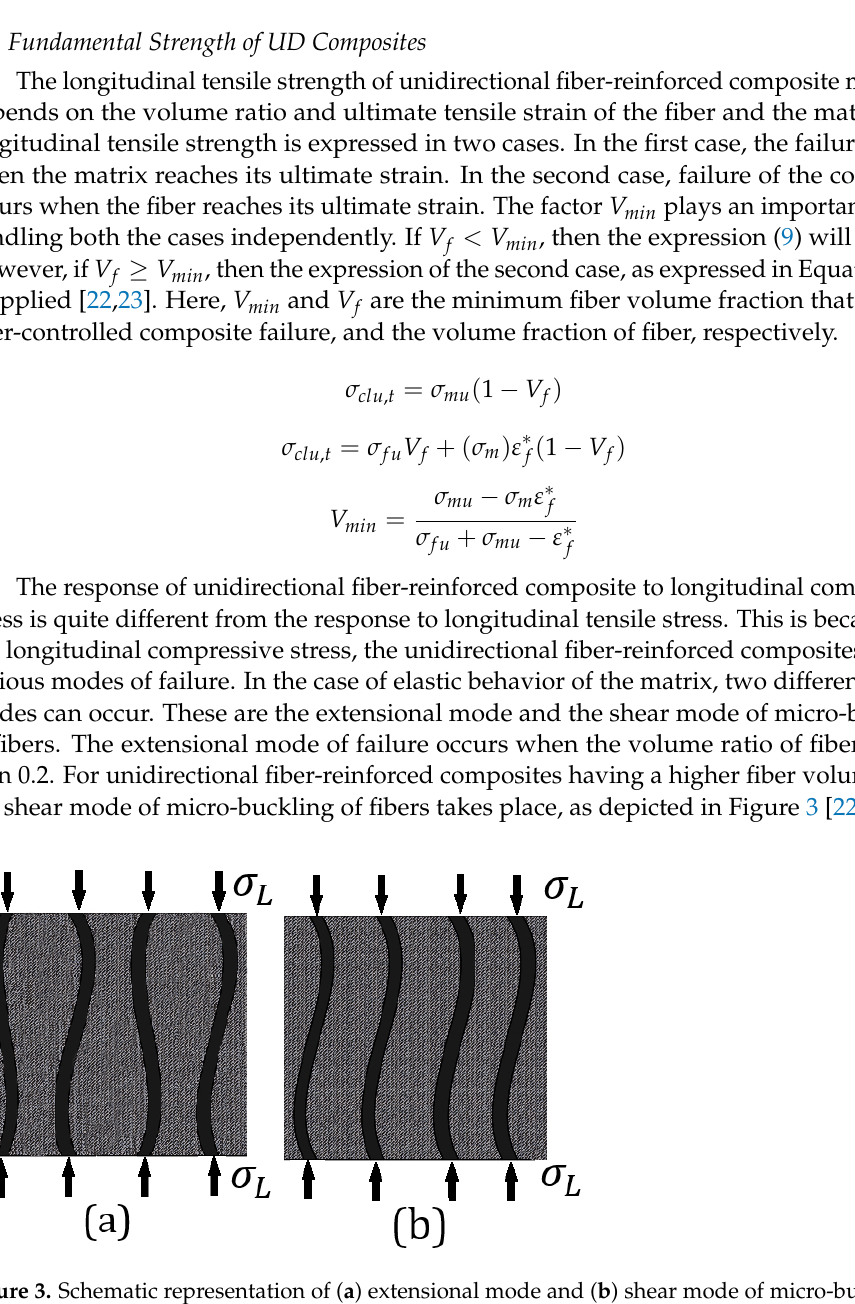
Figure 3. Schematic representation of ( a ) extensional mode and ( b ) shear mode of micro-buckling of fibers (Figure adapted from